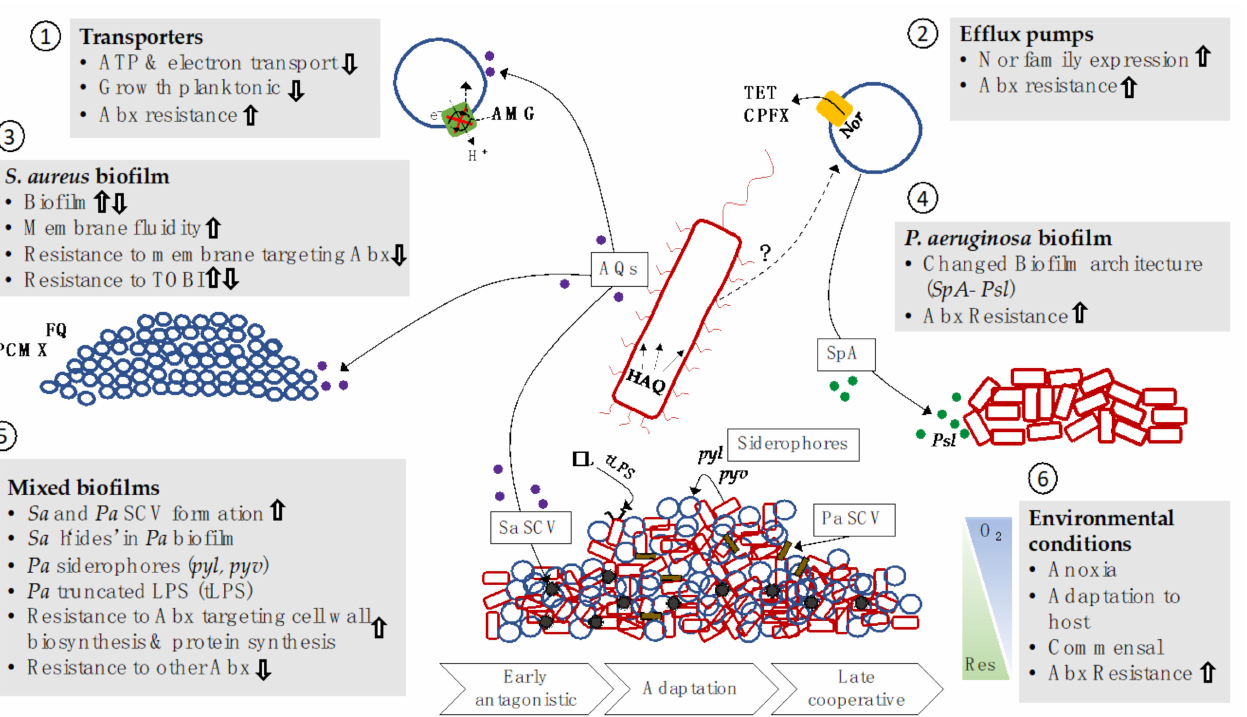
Figure 1. P. aeruginosa and S. aureus interactions leading to changes in antibiotic resistance. ( 1 ) AQs produced by Pa impact Sa planktonic growth, decreasing ATP generation and active transport and so uptake of AMG. ( 2 ) Sa Nor efflux pumps are upregulated in the presence of Pa , causing increased resistance to TET and CPFX. ( 3 ) Pa produced AQs, HQNO, and HAQ increase Sa biofilm production and membrane fluidity and decrease resistance to membrane-targeted antibi- otics. Studies differ in increase/decreased resistance to TOBI and increase/decrease Sa biofilm. ( 4 ) Sa -produced SpA interacts with Pa exopolysaccharide Psl , changing Pa biofilm architecture and resistance to antibiotics. ( 5 ) Prolonged mixed biofilms and long-term exposure to HQNO induce Sa SCVs. Pa in mixed biofilms increases siderophore production and produces truncated LPS both linked to AMR to antibiotics targeting cell wall biosynthesis and protein synthesis but unchanged or decreased resistance to other antibiotics. ( 6 ) Environmental conditions such as anoxia and adaptation to host increase antibiotic resistance and commensal cooperative behaviour. Pa = P. aeruginosa , Sa = S. aureus , Abx = antibiotics, AMG = aminoglycosides, SCV = small colony variant, TET = tetracycline, CPFX = ciprofloxacin, FQ = fluoroquinolones, PCMX = chloroxylenol, β L = beta-lactam, TOBI = tobramycin, SpA = Staphylococcal protein A, Psl = biofilm exopolysaccha- ride, pyl = pyochelin, pyv = pyoverdine, AQ = 2-alkyl-4-(1H)-quinolones, HQNO = 4-hydroxy-2-heptylquinoline-N-oxide, HAQ =